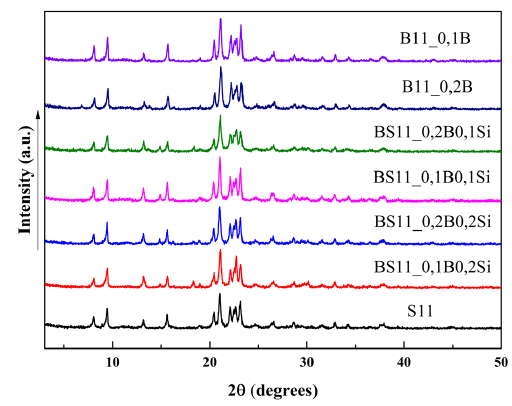
Figure 4. IR spectra in the range of 2000-400 cm -1 of AFI samples with and without boron added to different